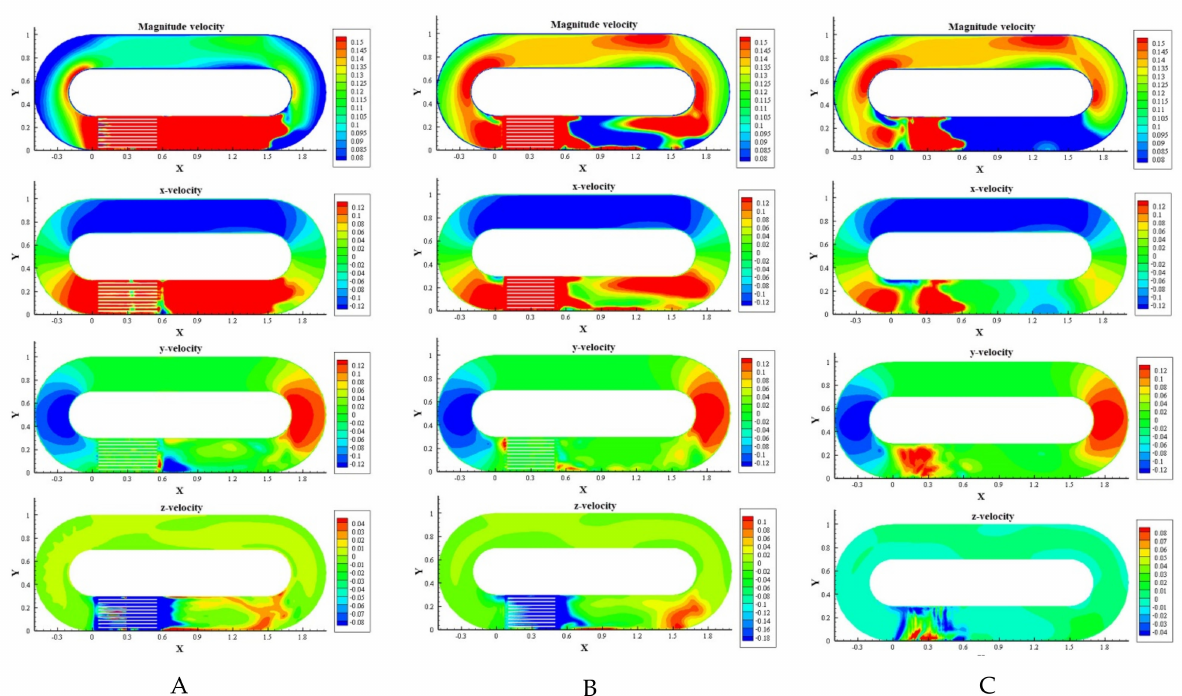
Figure 5. 3D velocity distribution at different elevations in flume. ( A ) z = 2 cm, ( B ) z = 15 cm, ( C ) z = 28